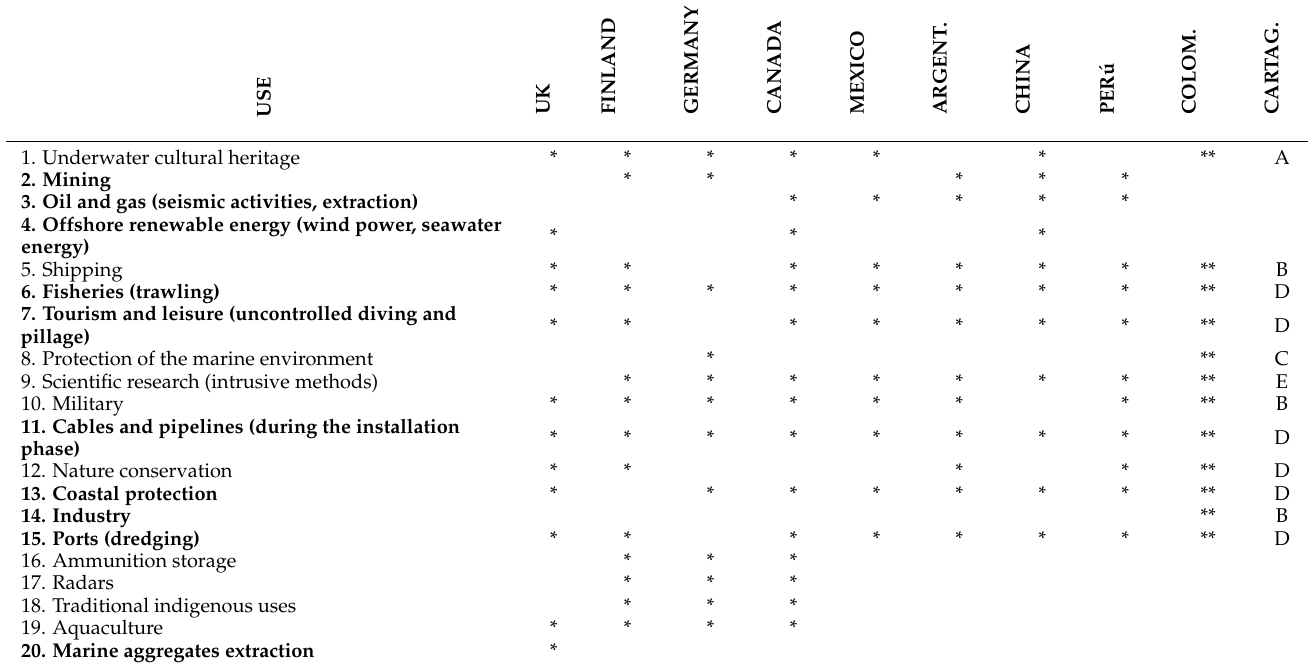
Table 8. Maritime activities/uses described by UNESCO [31,41,55]. Uses present in Cartagena Bay, Colombia. In bold potentially dangerous activities for UHC. Source: * [31]; ** [41]; A. [64]; B. [43]; C. [65]; D. [42]; E.